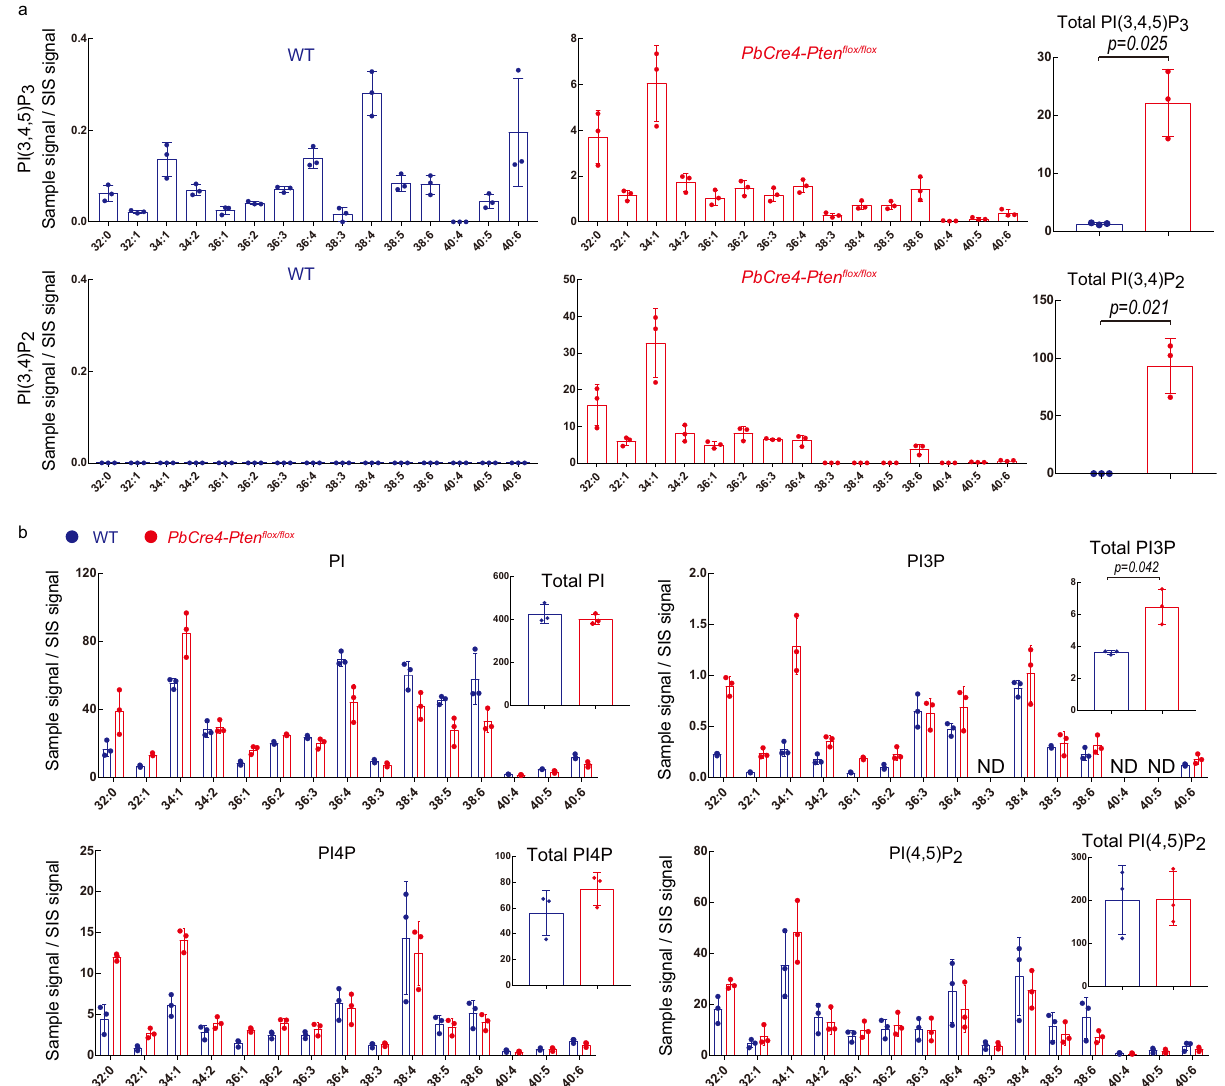
Fig. 3 Application of PRMC-MS to phosphoinositide measurement in mouse tissue. a Left and middle panels: Quanti fi cation of the indicated PI(3,4,5)P 3 and PI(3,4)P 2 acyl variants in prostate tissues from WT and prostate-speci fi c Pten -de fi cient ( PbCre4-Pten fl ox/ fl ox ) mice at 12 weeks of age ( n = 3 independent animals/group). The altered acyl chain pro fi le in Pten -de fi cient cancerous tissues was con fi rmed in fi ve independent experiments. Right panel: Total of the PI(3,4)P 2 and PI(3,4,5)P 3 acyl variants in the tissues in the left and middle panels. b Measurements of the indicated acyl variants and total PI, PI3P, PI4P, and PI(4,5)P 2 in the prostate tissues from the WT (blue) and PbCre4-Pten fl ox/ fl ox (red) mice in ( a ) (12 weeks of age, n = 3). For all panels, data were the mean ± SD ( n = 3 independent animals). ND not determined. The signi fi cance between WT and PbCre4-Pten fl ox/ fl ox mice was analyzed using a two-sided Welch ’ s t -test. Source data are provided as a Source Data fi